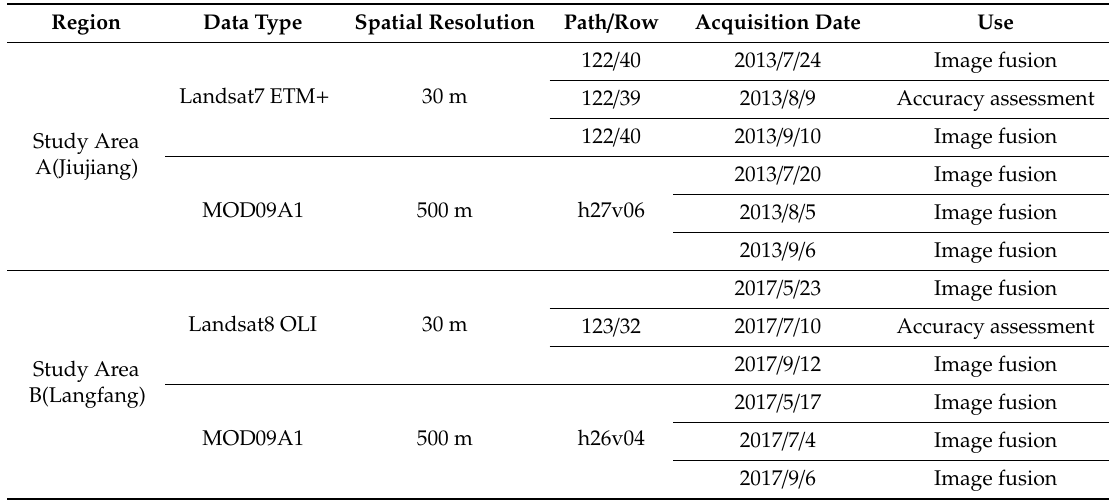
Table 2. Remote sensing data types and acquisition